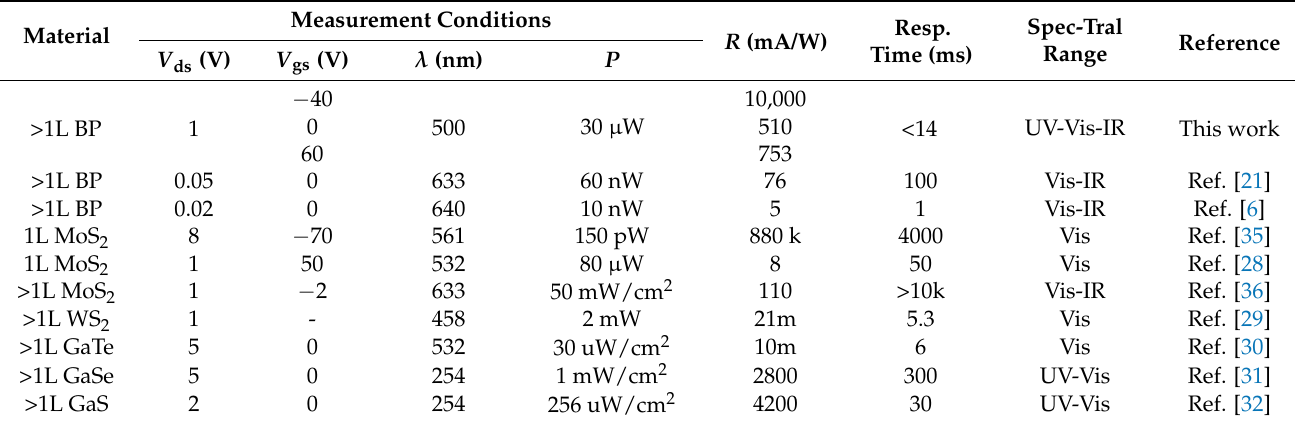
Table 1. Comparison of figures of merits for photodetectors based on 2D